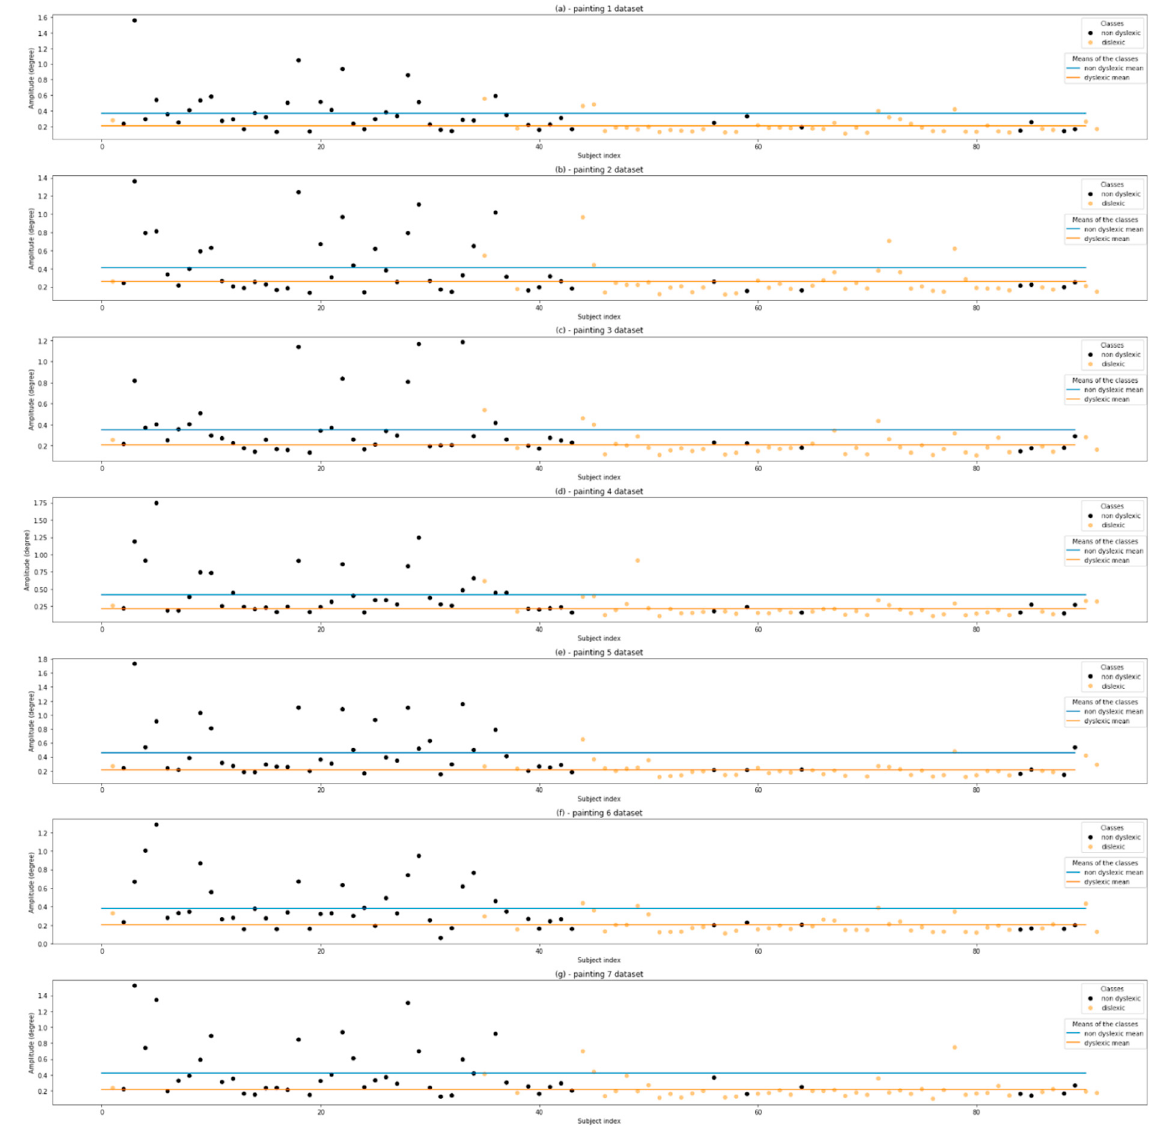
Figure A4. Amplitude. Subfigure ( a – g ) present the mean amplitude of the DGI segments for each patient for the Painting 1, 2, 3, 4, 5, 6, 7 Dataset, respectively.